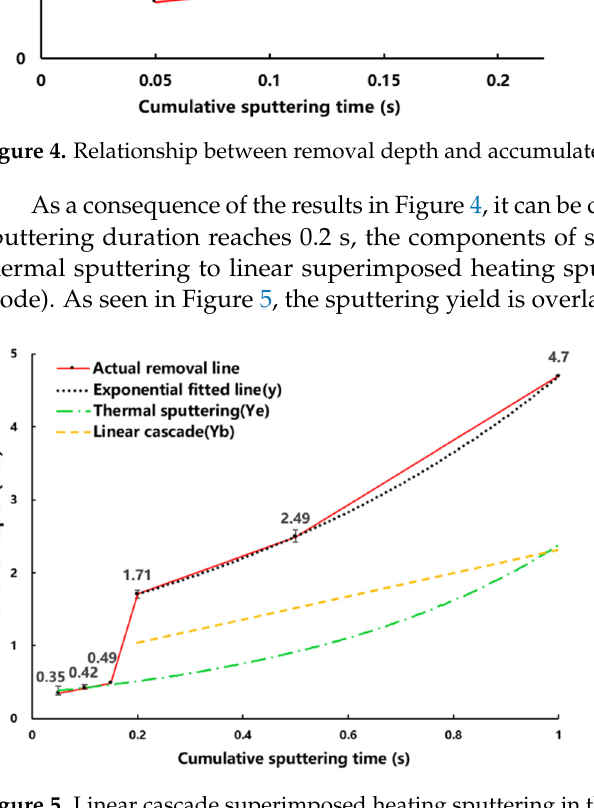
Figure 5. Linear cascade superimposed heating sputtering in thermal spot mode.